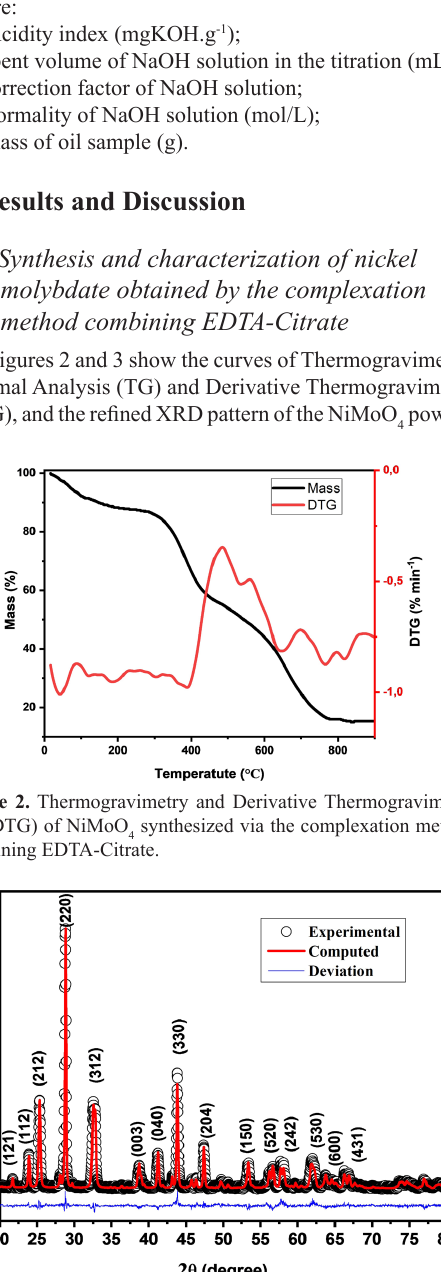
Figure 3. Refined XRD pattern of the NiMoO at 800